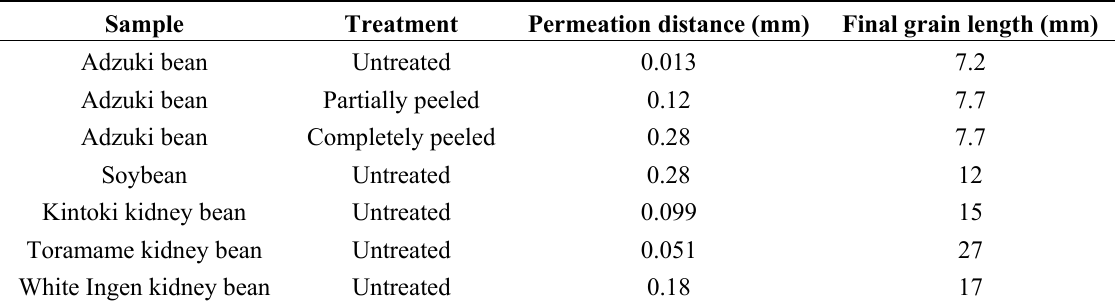
Table 3. Water permeation distance of adzuki bean, soybean, kintoki kidney bean, toramame kidney bean, and white ingen kidney bean during soaking in water for 10 min, and final grain length. Sample Treatment Permeation distance (mm) Adzuki